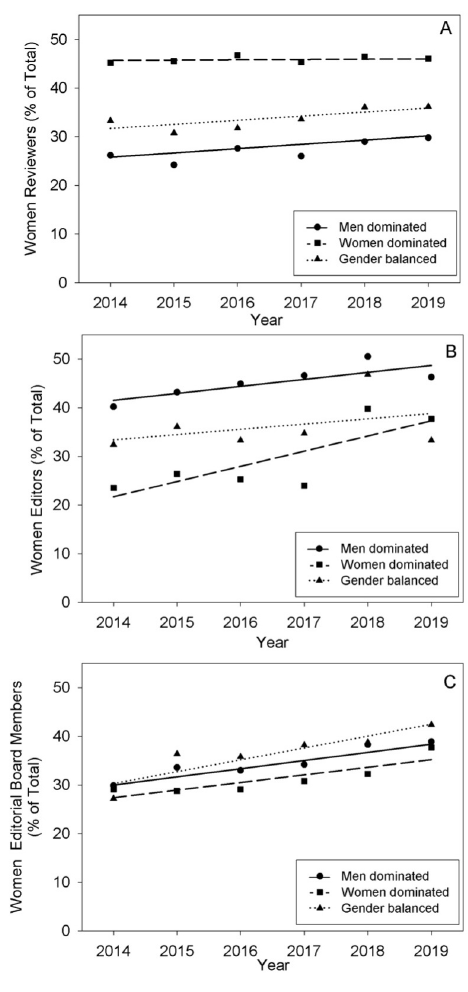
Figure 1. Annual (2014–2019) mean